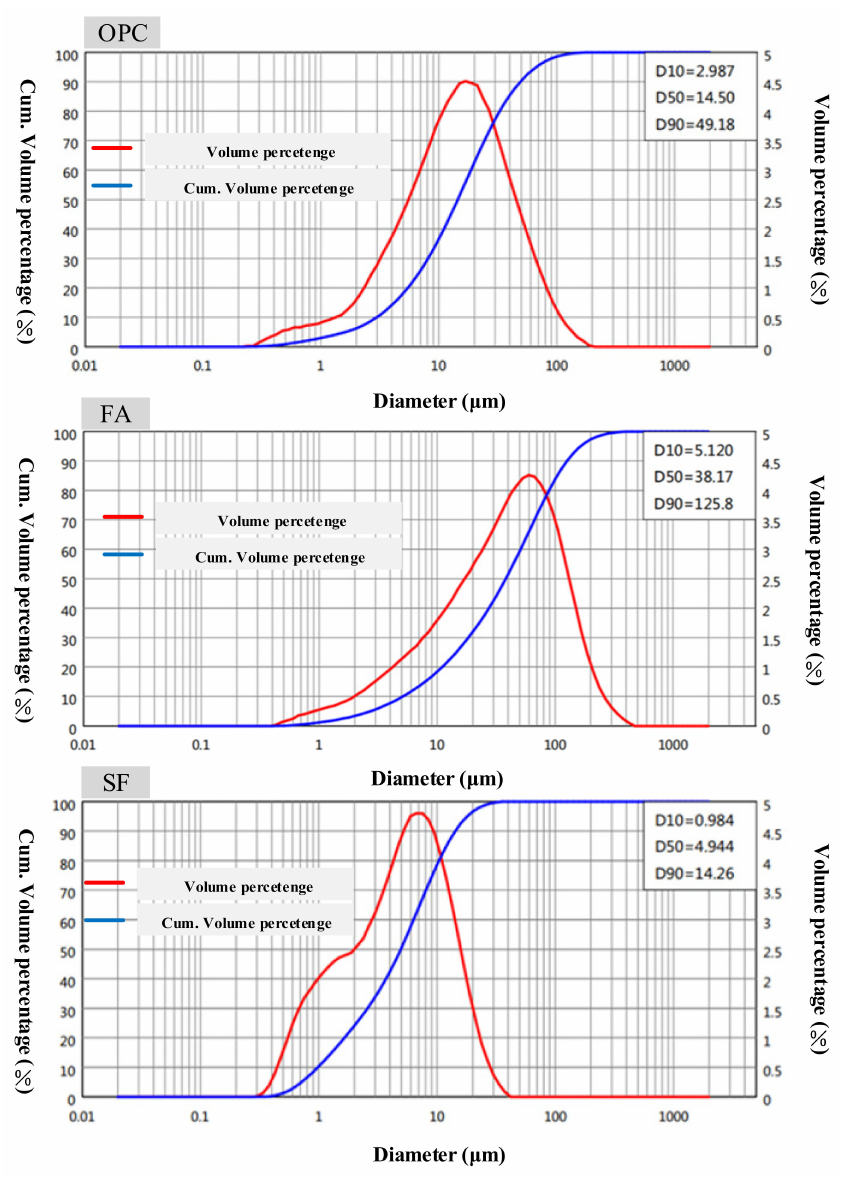
Figure 1. Particle size distributions of OPC, FA and SF. The morphology of cement, fly ash, and silica fume particles was analyzed by scanning electron microscope (Carl Zeiss AG, Oberkochen, Germany), as shown in Figure 2. From the results, it can be seen that the particle size of fly ash was similar to a round shape, which can play a lubricating effect. The shape of SF was irregular prismatic, which affected the fresh properties of cement paste mainly through filling and surface effects. It can be seen from the Figure 2 that the particle size of SF was significantly smaller than FA, which conforms to the particle distribution curve shown in Table